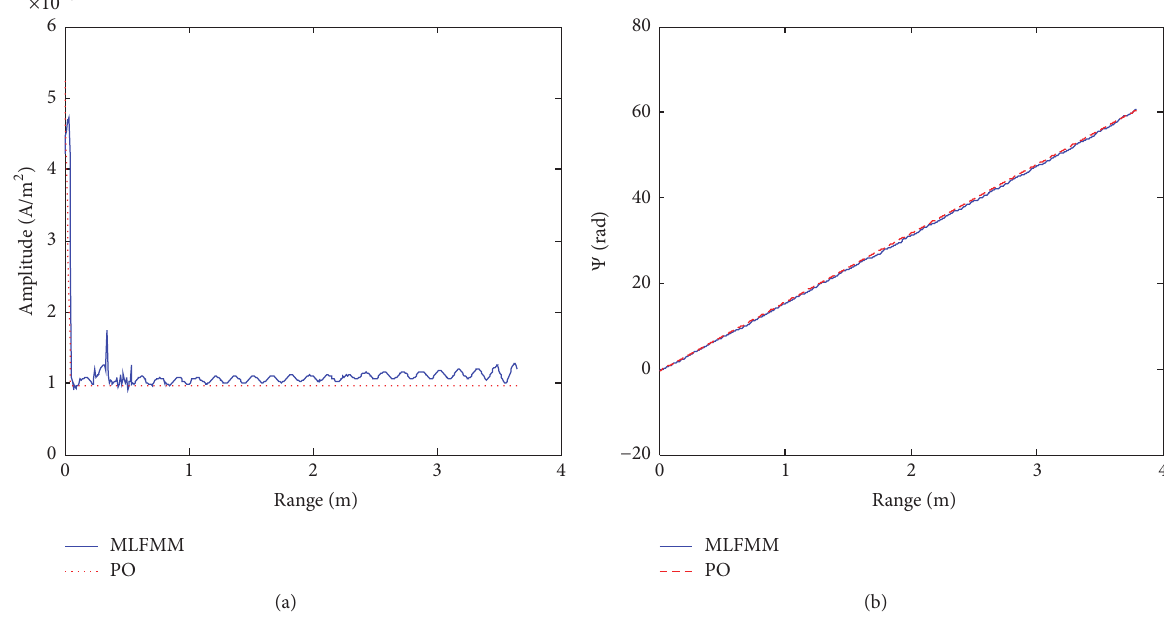
Figure 3: Amplitude and phase of the currents on 𝐿1 . (a) Amplitude; (b) unwrapped